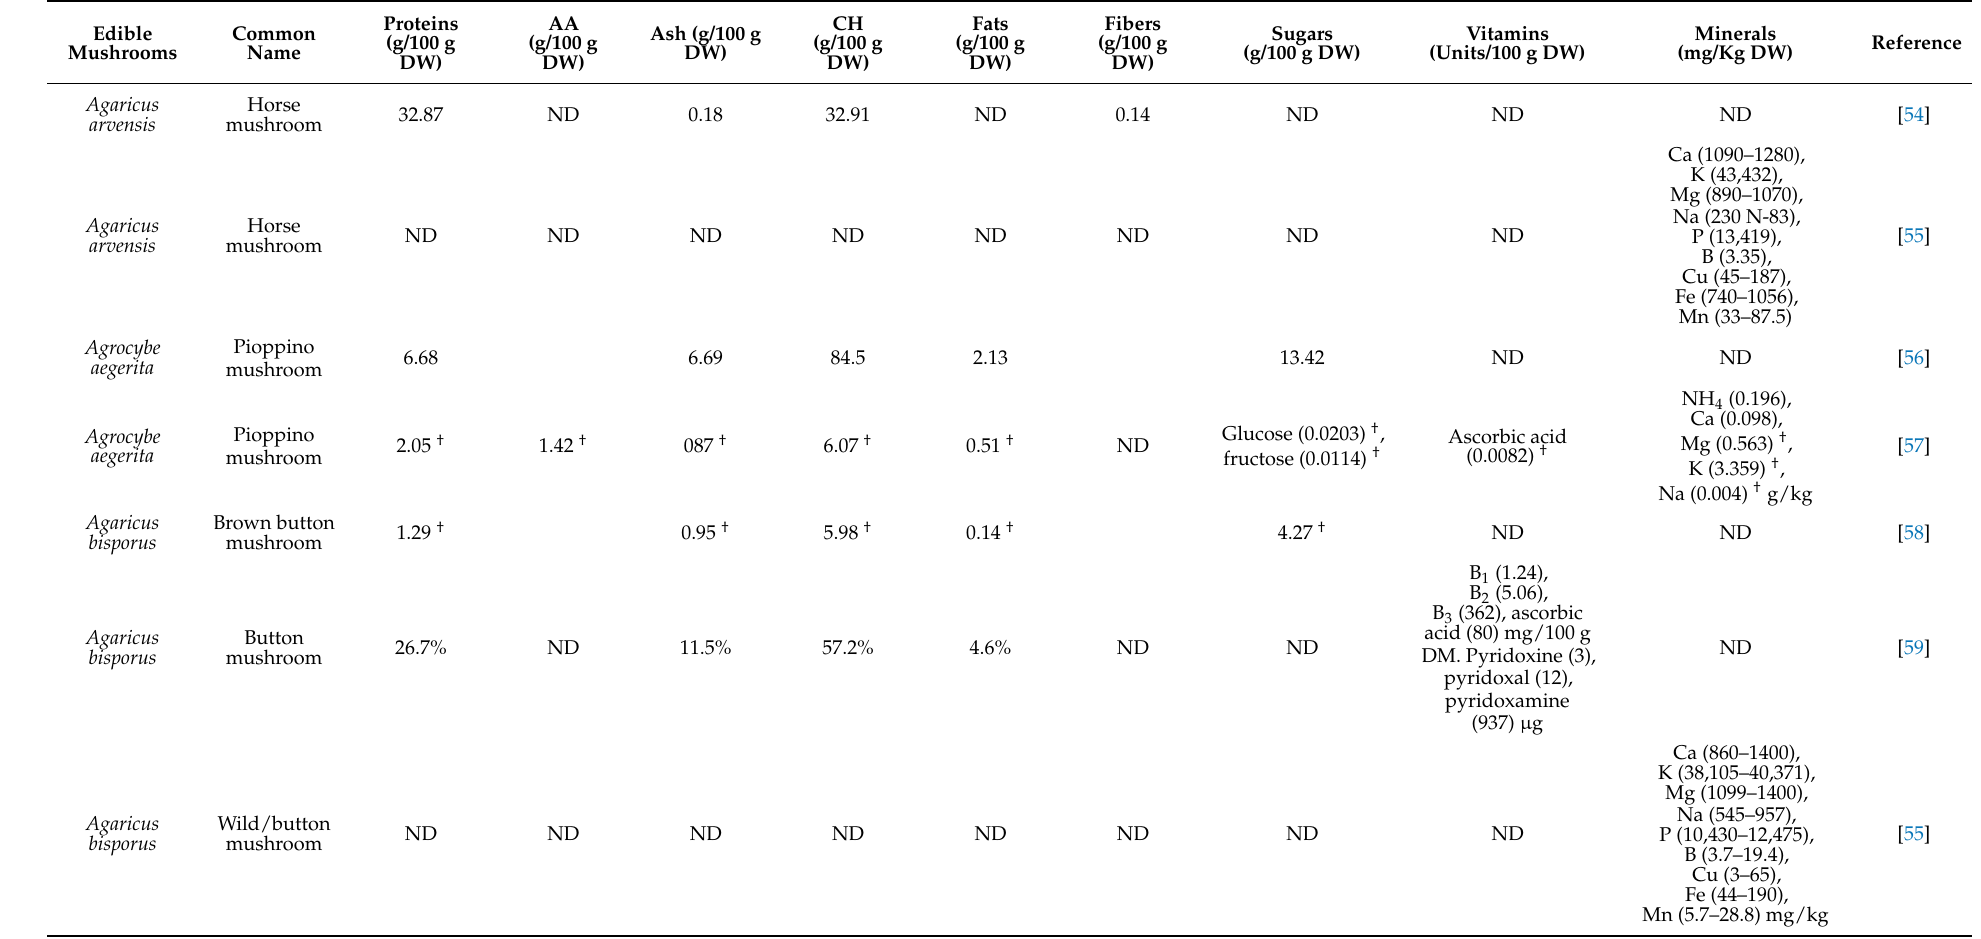
Table 1. Nutritional aspects of edible